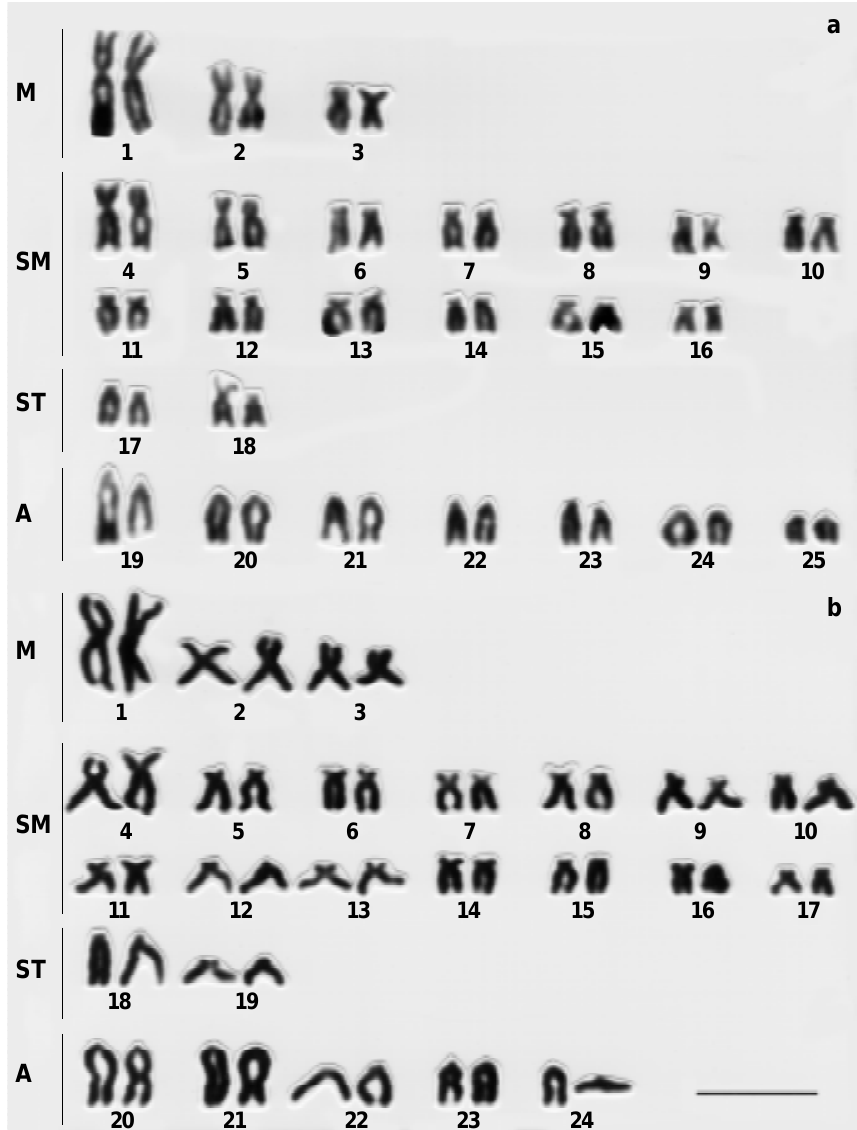
Figure 1 - Karyotypes of A. scabripinnis collected from the Tamanduá stream. a , Cytotype I (2n = 50), and b , cytotype II (2n = 48). Bar = 10 m